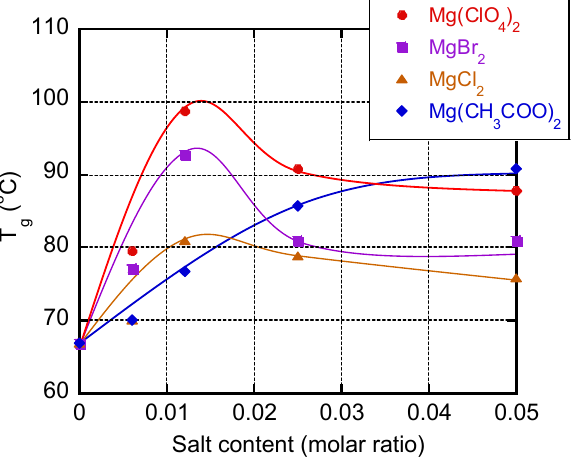
Figure 5. Relationship between the glass transition temperature ( T g ) and the salt content.